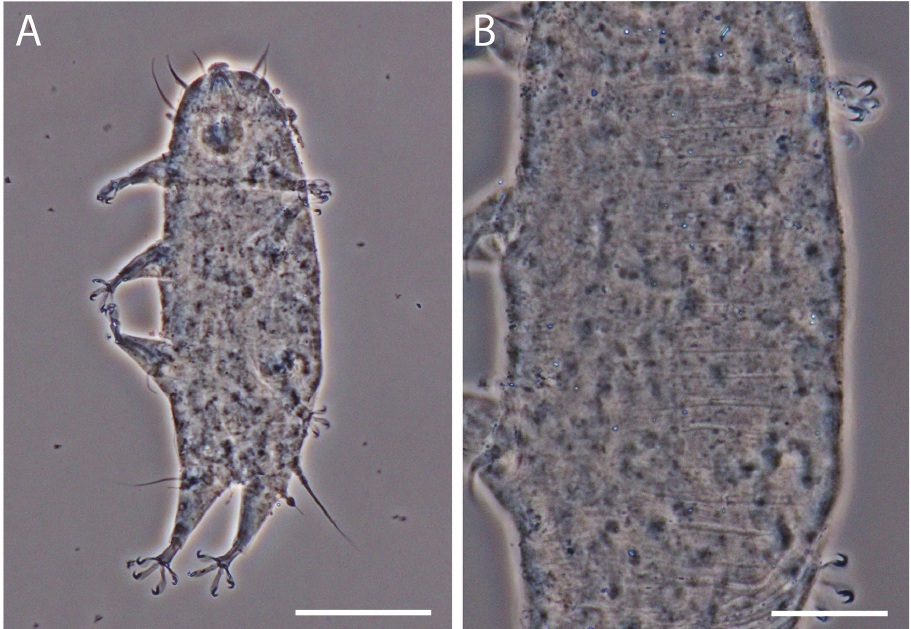
Figure 8. Phase contrast micrograph of Styraconyx sp. A ventral view, scale bar = 50 μm B dorsal cuticle with ridges, scale bar = 20